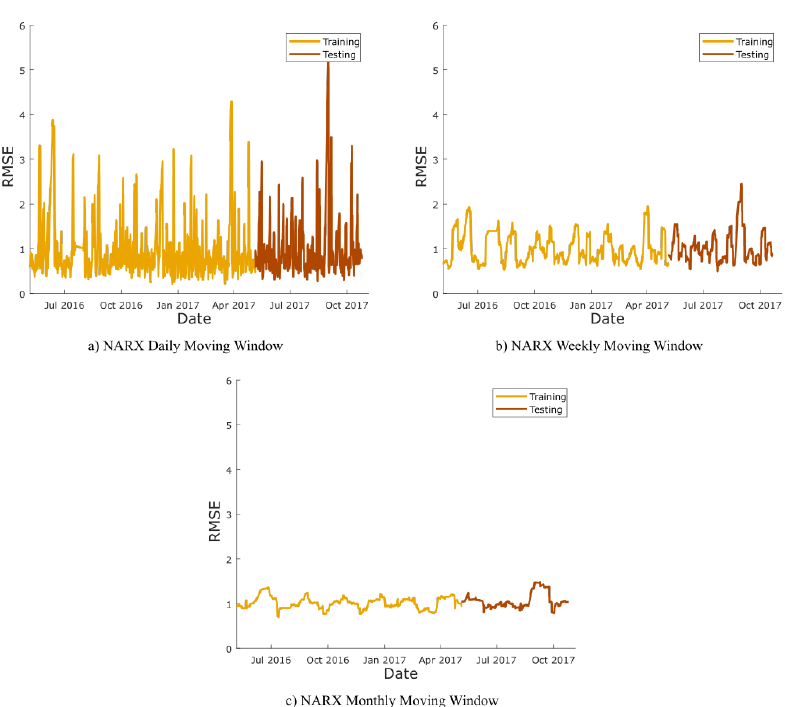
Figure 8. Effect of window length for Moving RMSE for NARX model with 12 month training period and 10 min time resolution.